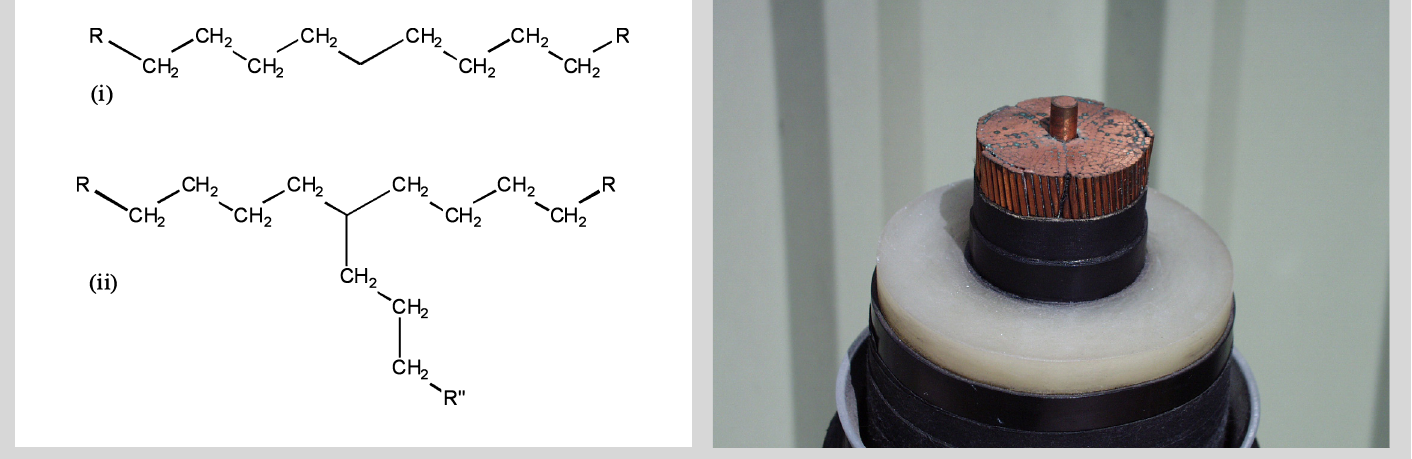
Figure 1 (left): One monomer, many poly- mers: linear polythene pro- duce using the Ziegler-Natta process (i) and a long-chain branched comb-structured polythene (ii) produced by Professor Walter Kaminsky using the tandem action of two single-site catalysts [2]. Figure 2: Full Circle: Originally designed for its potential as an insulating material, the many difficulties involved in the design of polyethylene insulated high-power trans- mission cables presented a major challenge; however cables such as the one shown here are now replac- ing the older oil and paper versions, and may have a number of environmental